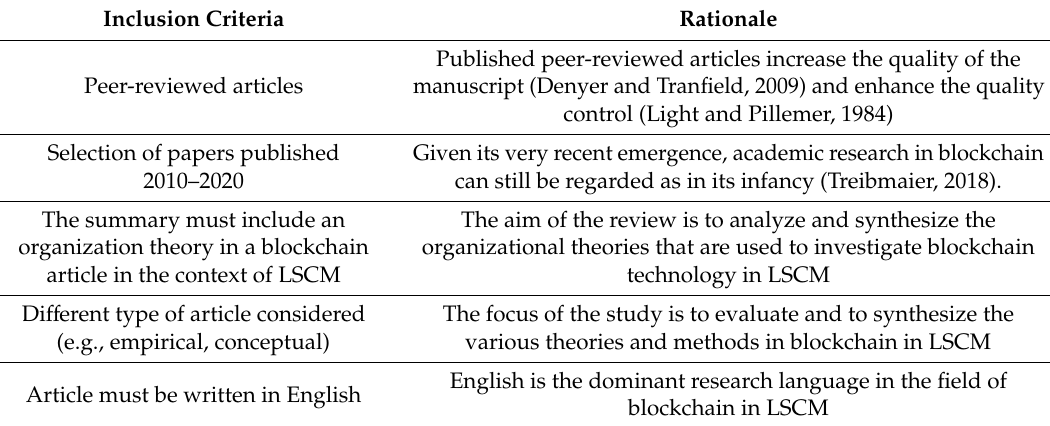
Table 1. Inclusion Criteria.